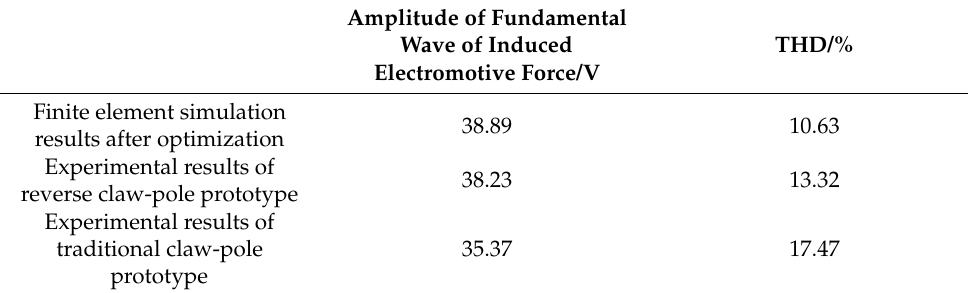
Figure 17. No-load induced electromotive force harmonic distribution. Table 7. Data comparison of experimental results.